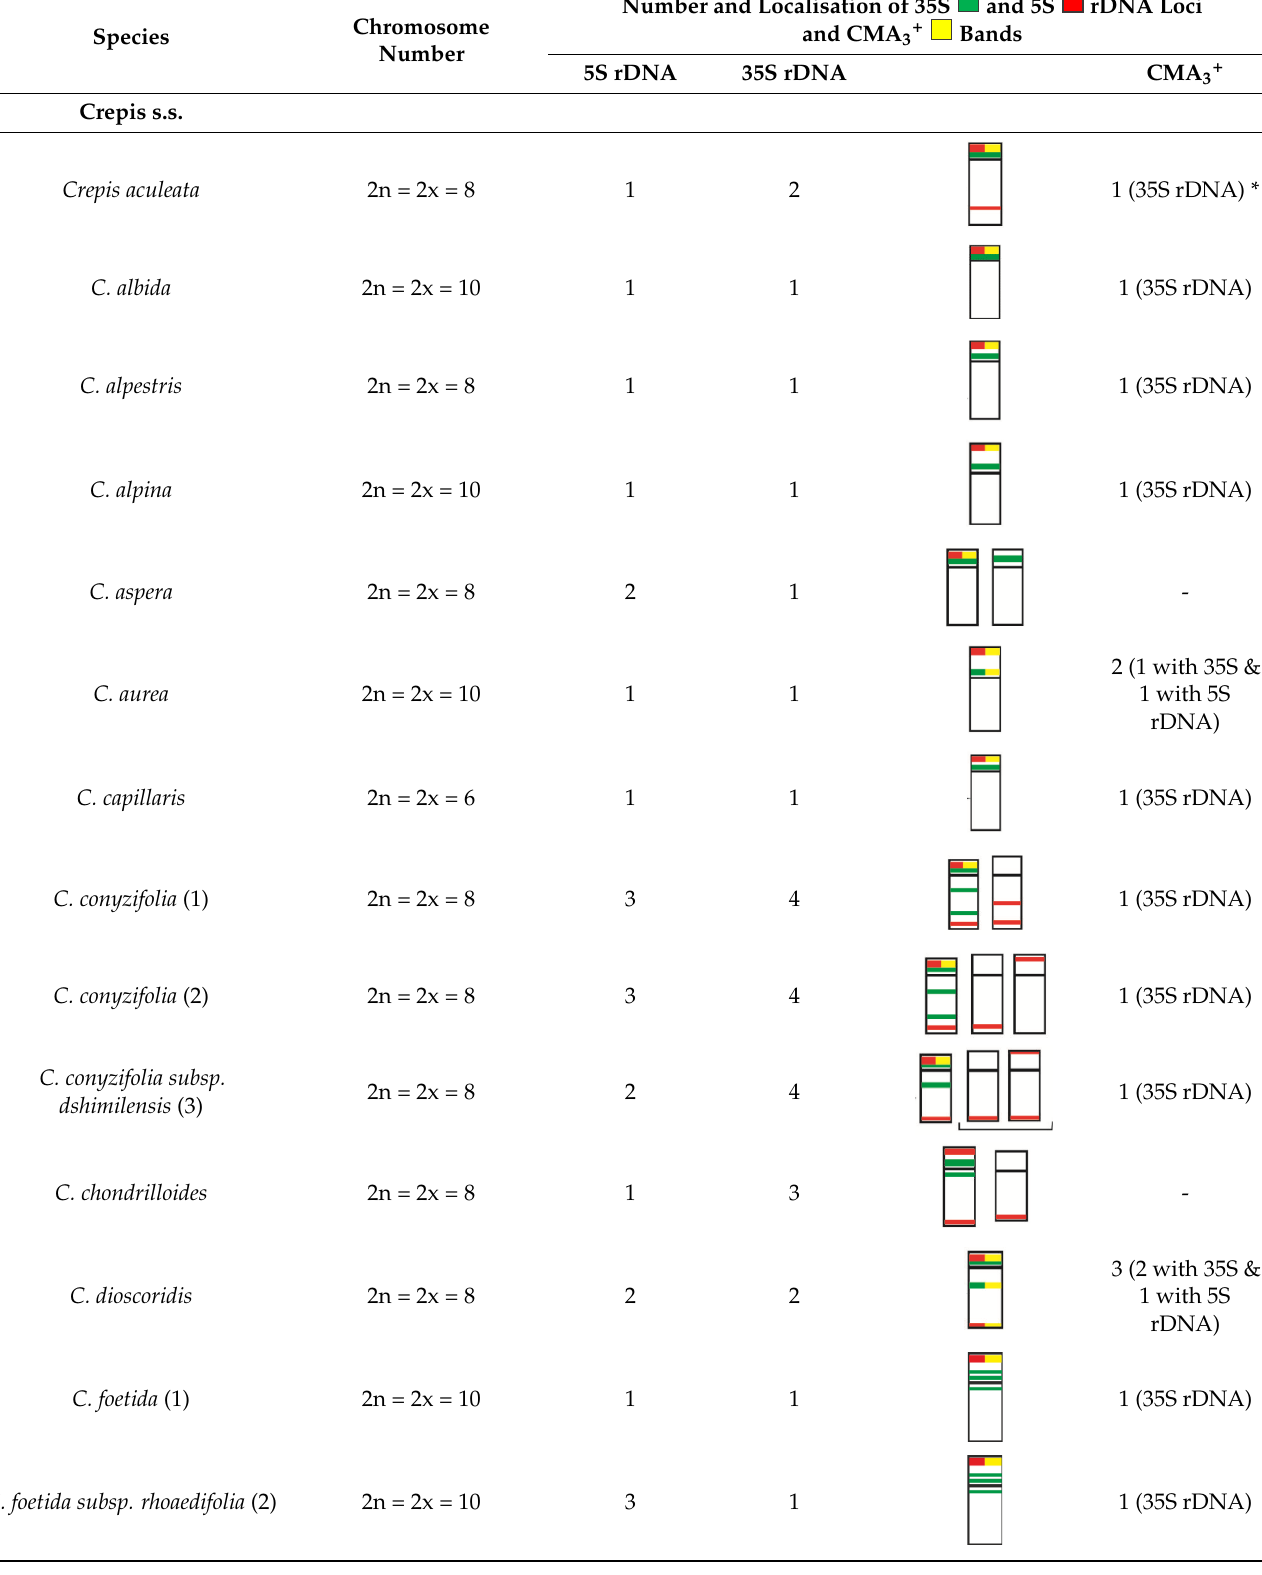
Table 1. The number and localisation of the 35S and 5S rDNA loci and CMA 3+ bands in Crepis.